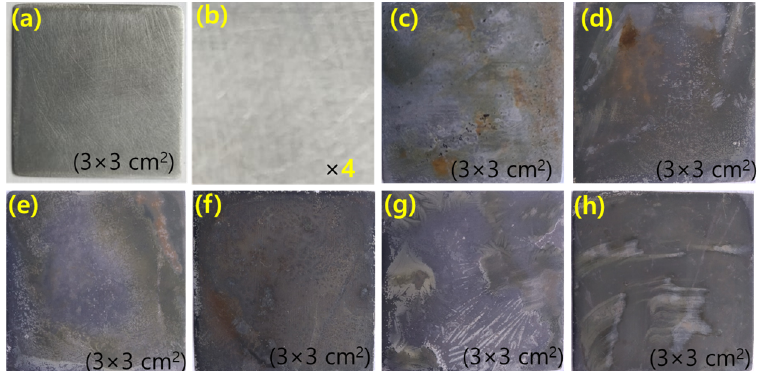
Figure 5. The digital images of MS surface ( a , b ) polished MS at different magnification, ( c ) after dipping in 1M H 2 SO 4 for 1 h, ( d – h ) after dipping in 200, 400, 600, 800, 1000 ppm green inhibitor respectively for 1 h at 25